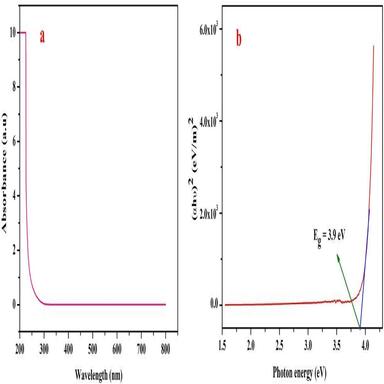
(a) UV–vis profile and (b) Tauc's plot of LHFFAM.